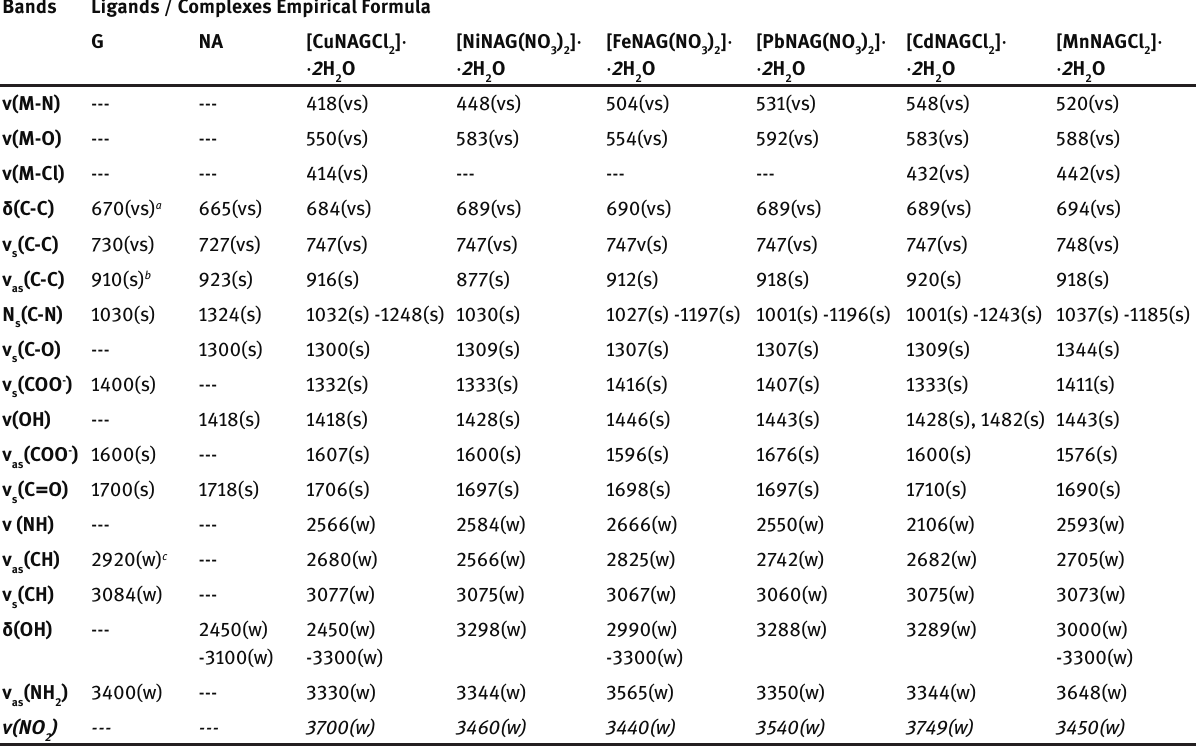
Table 2: Infra-red (IR) spectral bands frequencies (cm -1 ) of mixed vitamin B3 (NA) – glycine (G) –metal complexes. Bands Ligands / Complexes Empirical